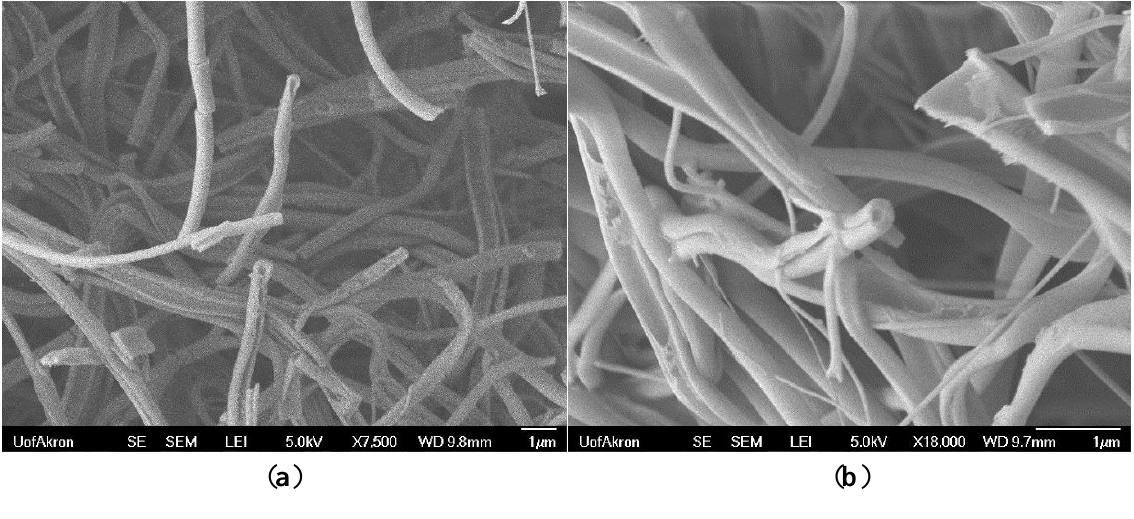
Figure 9. High resolution FE - SEM images showing the hollow fiber structure at ( a ) 7,500×; and ( b ) 18,000×